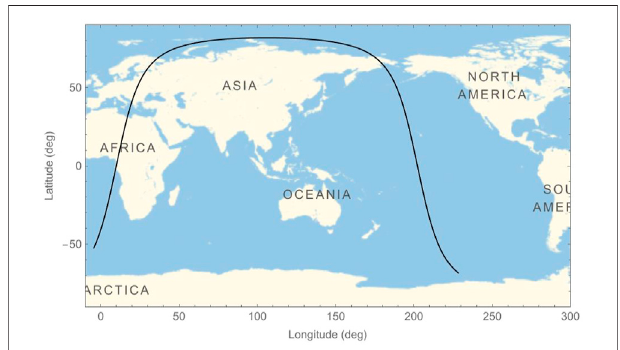
FIGURE 3 | Orbital path of the GEOS and lidar simulations shown in Figure 2 .